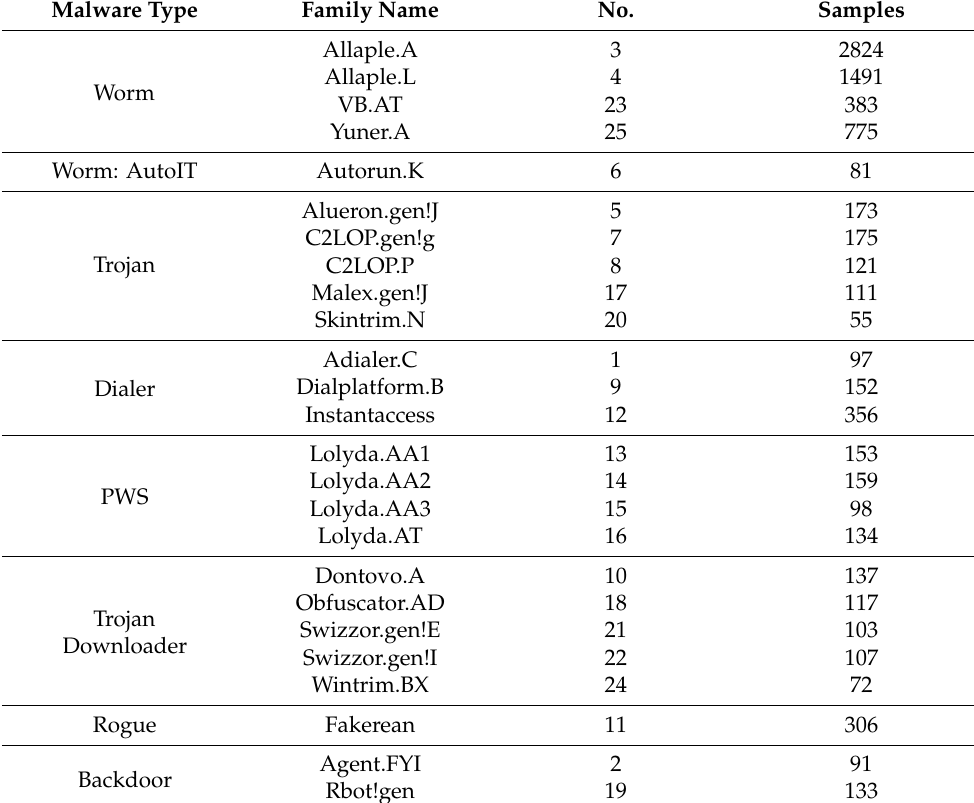
Table 4. Details of each malware family in the Malimg data